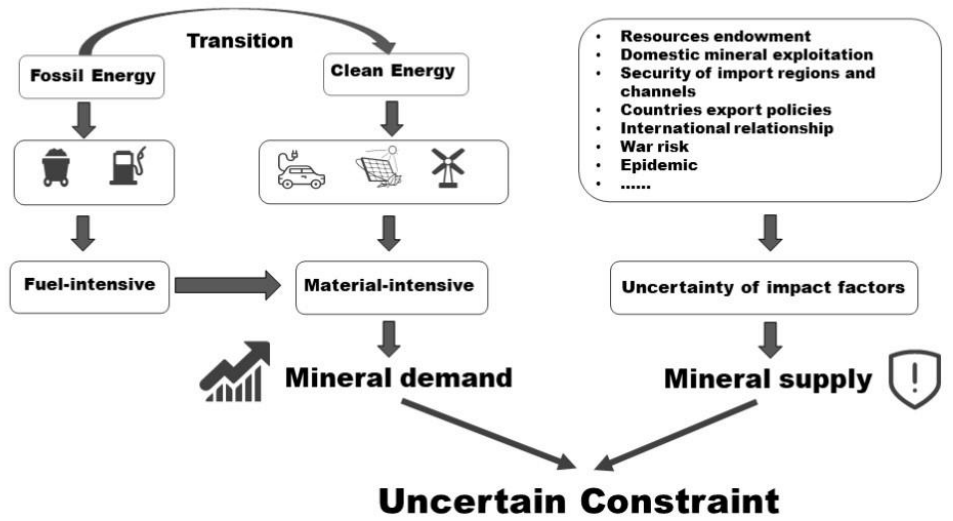
Figure 1. Potential constraints in the development of clean energy.